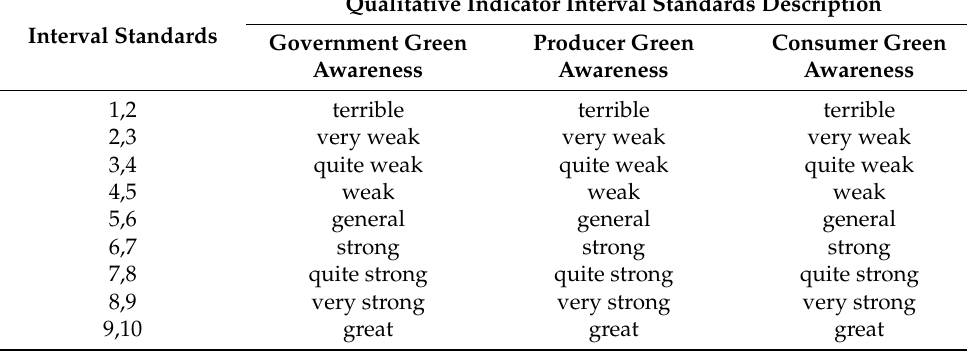
Table 2. Interval division standard and